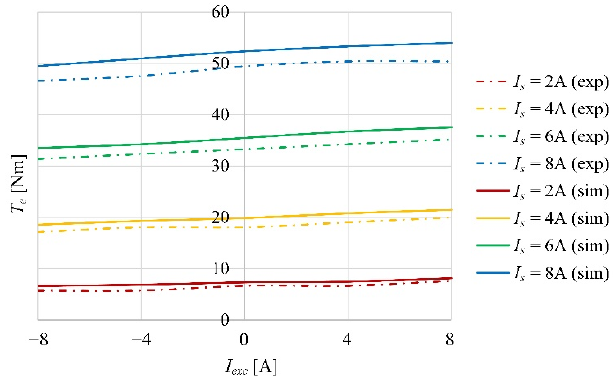
Figure 13. Electromagnetic torque vs. DC control coil current.